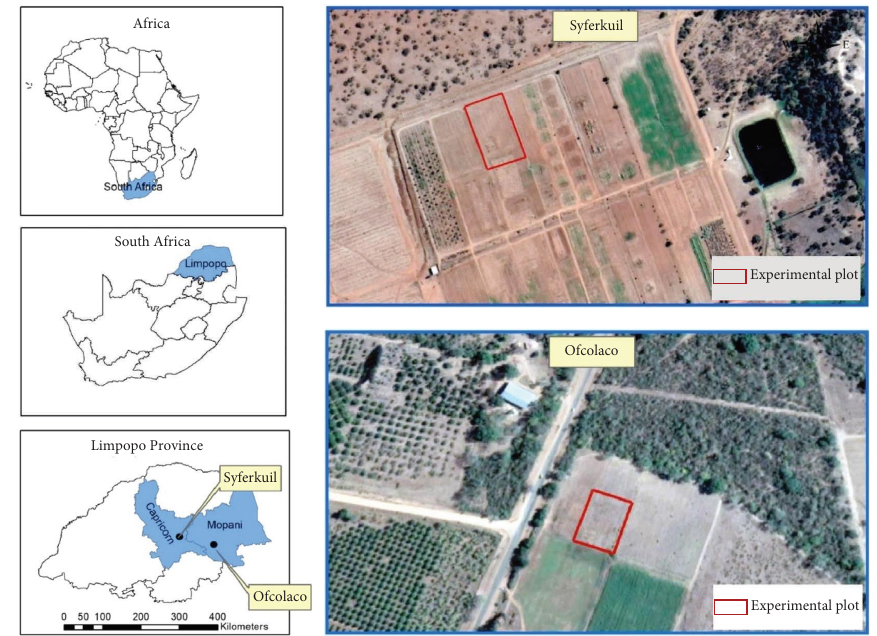
Figure 1: Te map of agroecological regions where the feld experiments were conducted during the 2018/19 and 2020/21 cropping seasons (Risk and Vulnerability Science Centre, University of Limpopo).